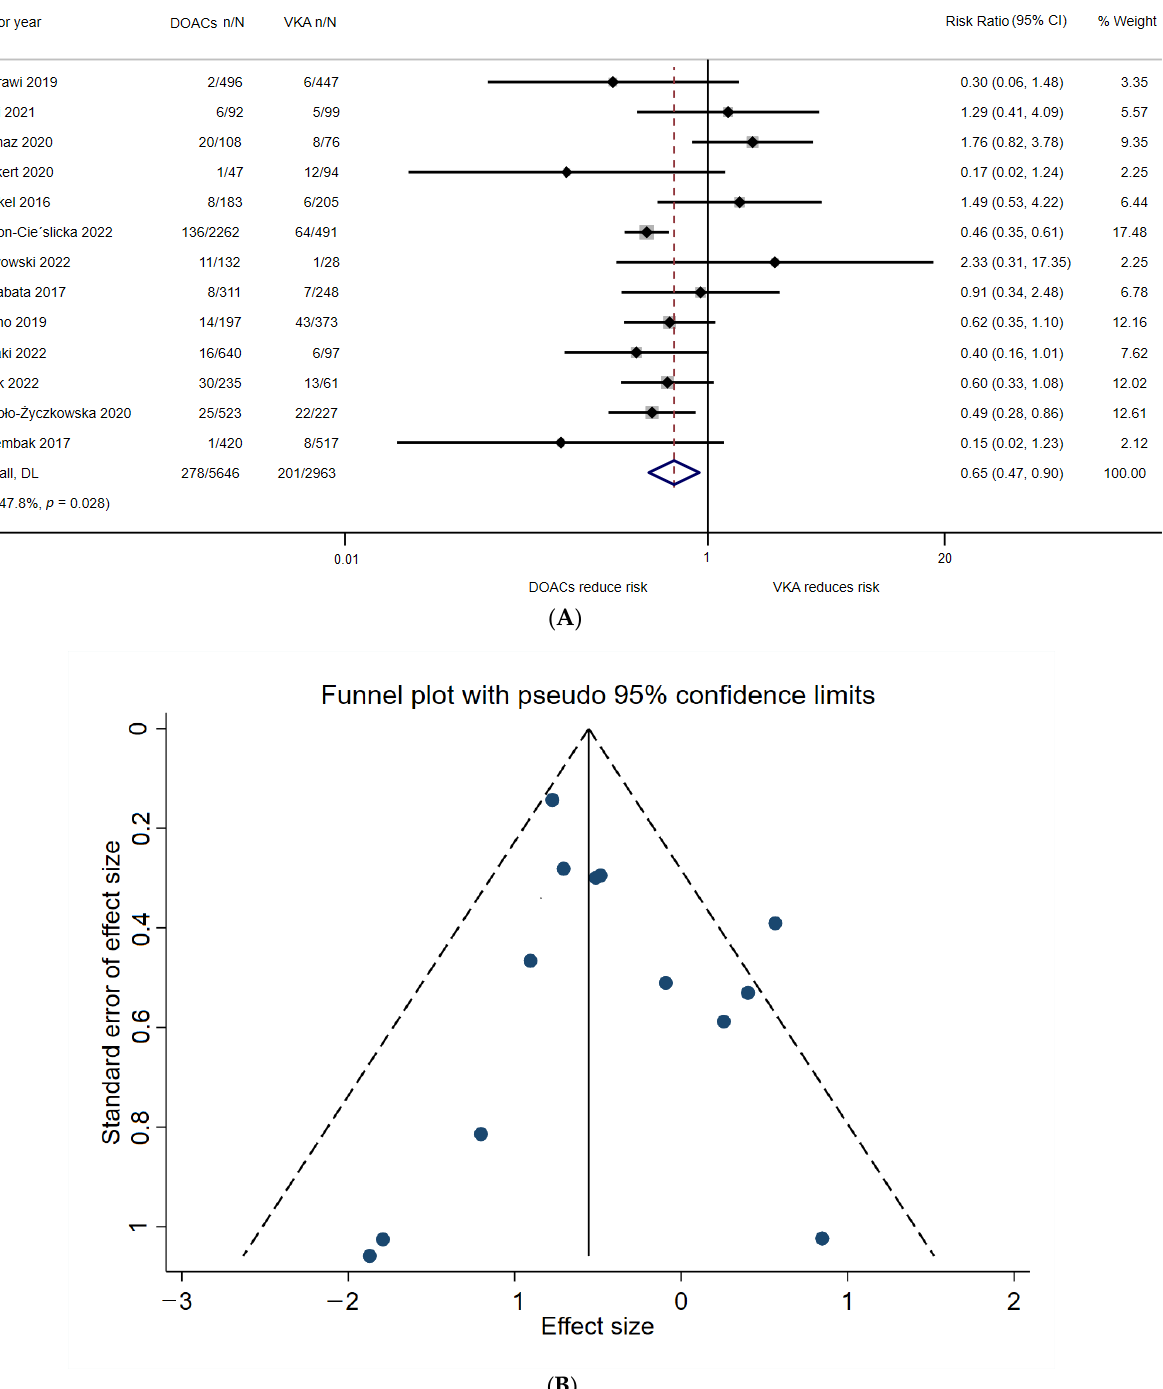
Figure 2. ( A ) The forest plot of random-effect meta-analysis of the incidence of left arterial appendage thrombus formation under the use of vitamin K antagonist (VKA) and direct oral anticoagulants (DOACs). ( B ) The funnel plot of the studies included in the meta-analysis of the incidence of left arterial appendage thrombus formation under the use of vitamin K antagonist (VKA) and direct oral anticoagulants (DOACs).